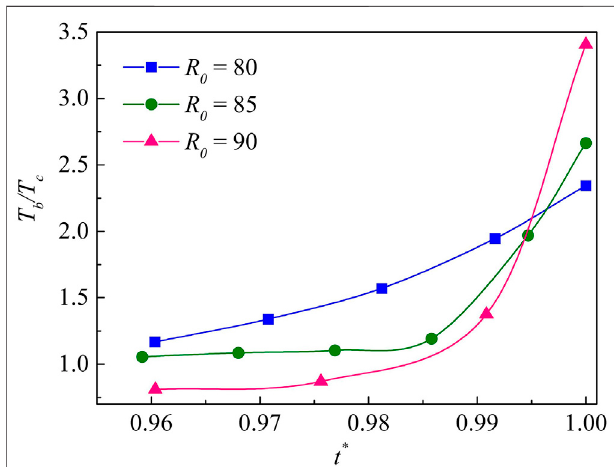
FIGURE 14 | Toroidal temperature vs. time during the second collapse for several values of R 0 .